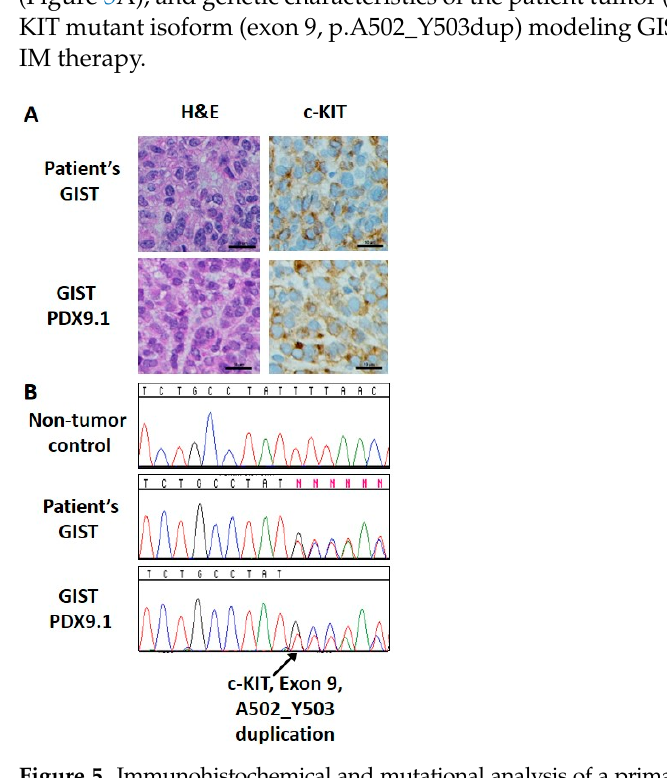
Figure 5. Immunohistochemical and mutational analysis of a primary GIST and matched PDX model. ( A ) H&E and c-KIT (CD117) staining for primary GIST (top) and matched GIST PDX9.1 (bottom). ( B )Sanger sequencing analysis identified the A502_Y503 duplication in exon 9 of KIT in both primary GIST